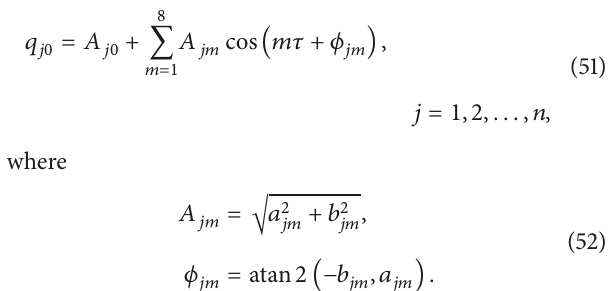
Figure 2: Inverted cantilevered flexible beam with a tip